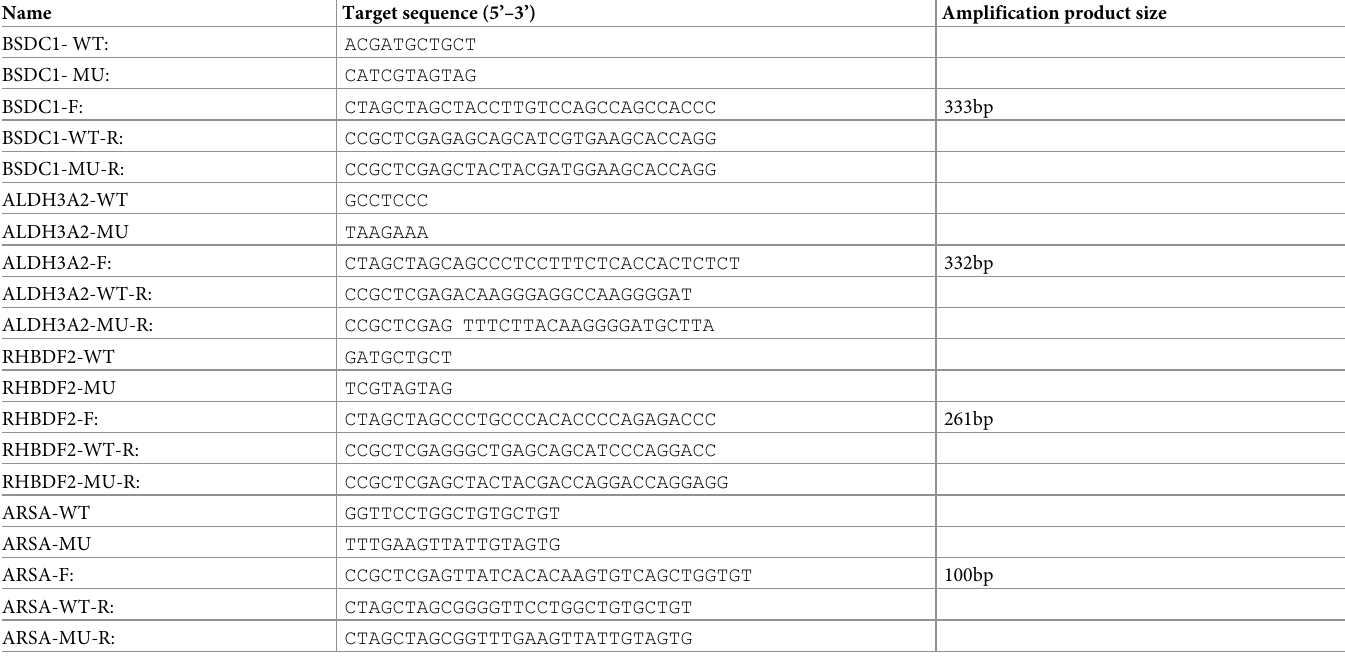
Table 1. Primers of targeting the seed region of the candidate target genes. Name Target sequence